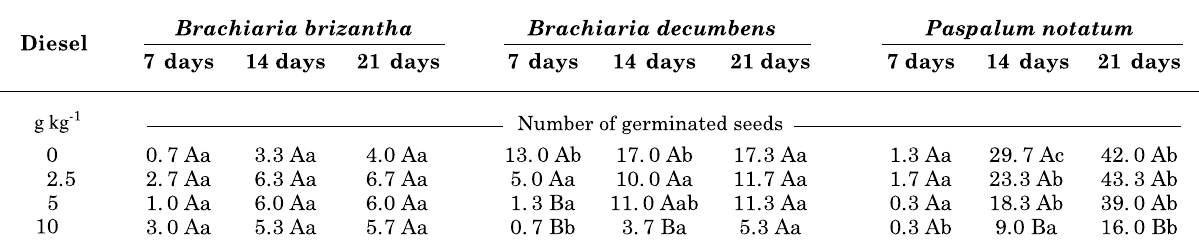
Average values of three replicates followed by different letters within columns (upper-case letters) and rows (lower-case letters) indicate statistical differences (mean comparison between species at the same time period); Tukey at 5